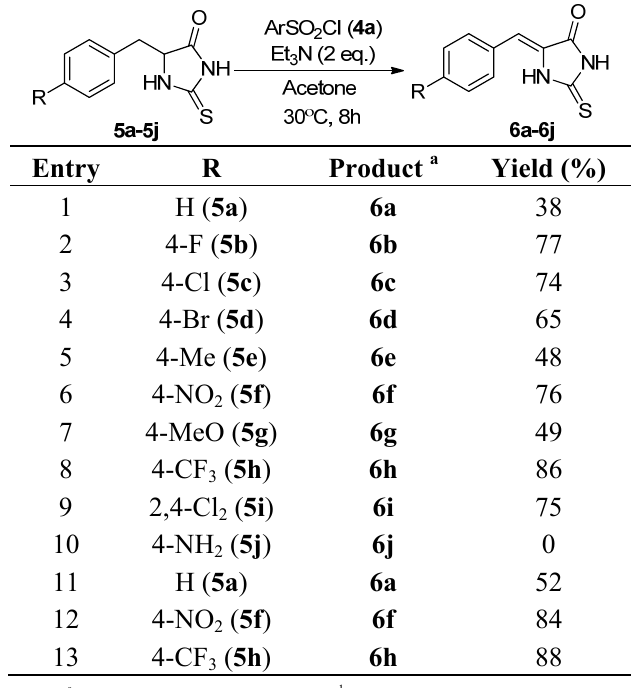
Table 3. The reaction of analogues 5 and arylsulfonyl chloride ( 4a ).